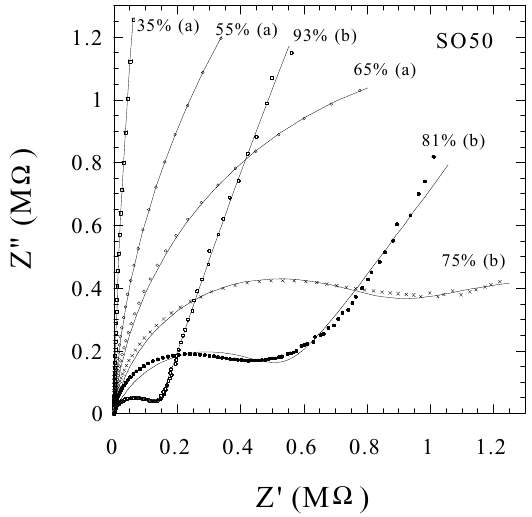
Figure 9. Cole-Cole plot of sensor SO50 as a function of humidity. The points represent the experimental data and lines the fit with the equivalent circuit model given in Figure 12. The RH values at which the data was collected and the equivalent circuit used for fitting each curve (given as (a) or (b) denoting the circuit of Figure 12a and 12b respectively) are shown adjacent to each